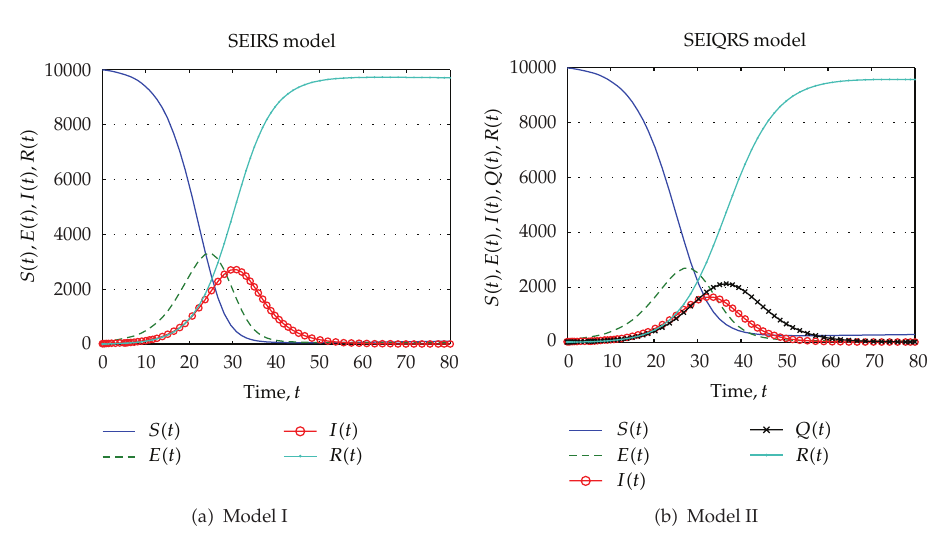
Figure 3: Numerical simulation for Model I and Model